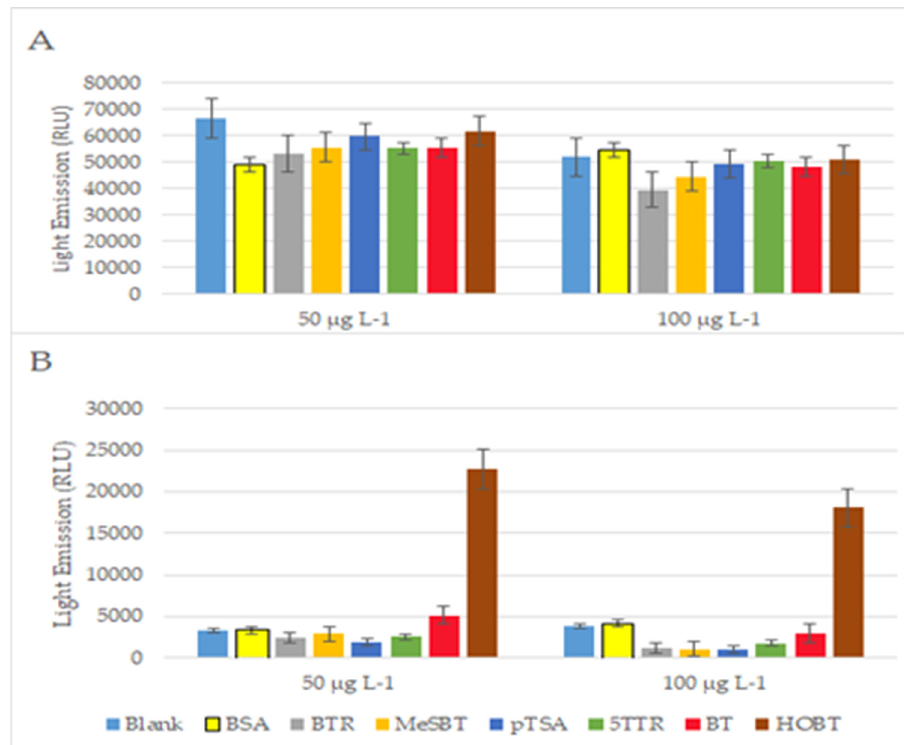
Figure 7. Bioluminescent bacteria light emission intensities recorded at short toxicity intervals (3 h ( A ) and 48 h ( B )) after contact with the various compounds at the 50 and 100 µg L − 1 concentration. With the exception of BSA, showing no effect, HOBT and BT at 50 µg L − 1 , shown eutrophic effects, and other compounds resulted in a clearer toxic effect.